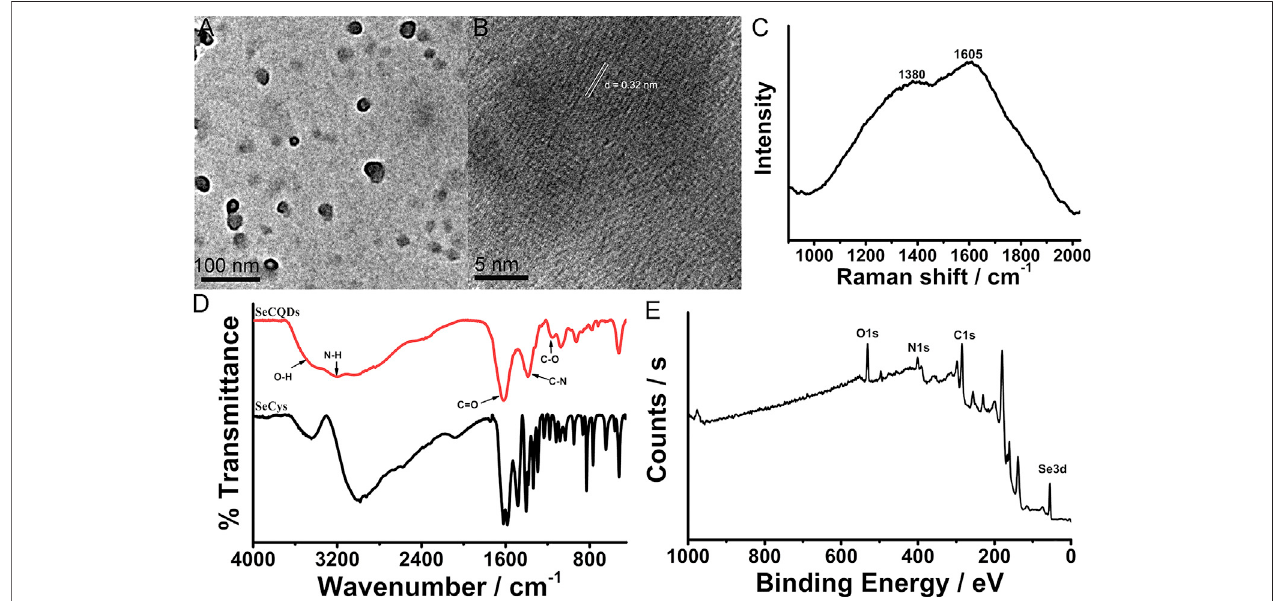
FIGURE2| Thecharacterizationoftheas-synthesizedSeCQDs.TEMimageofSeCQDs (A) .HRTEMimageofSeCQDs (B) .Ramanspectrum ofSeCQDs (C) .FT- IR spectra of SeCQDs and SeCys (D) . XPS spectrum of SeCQDs (E) .